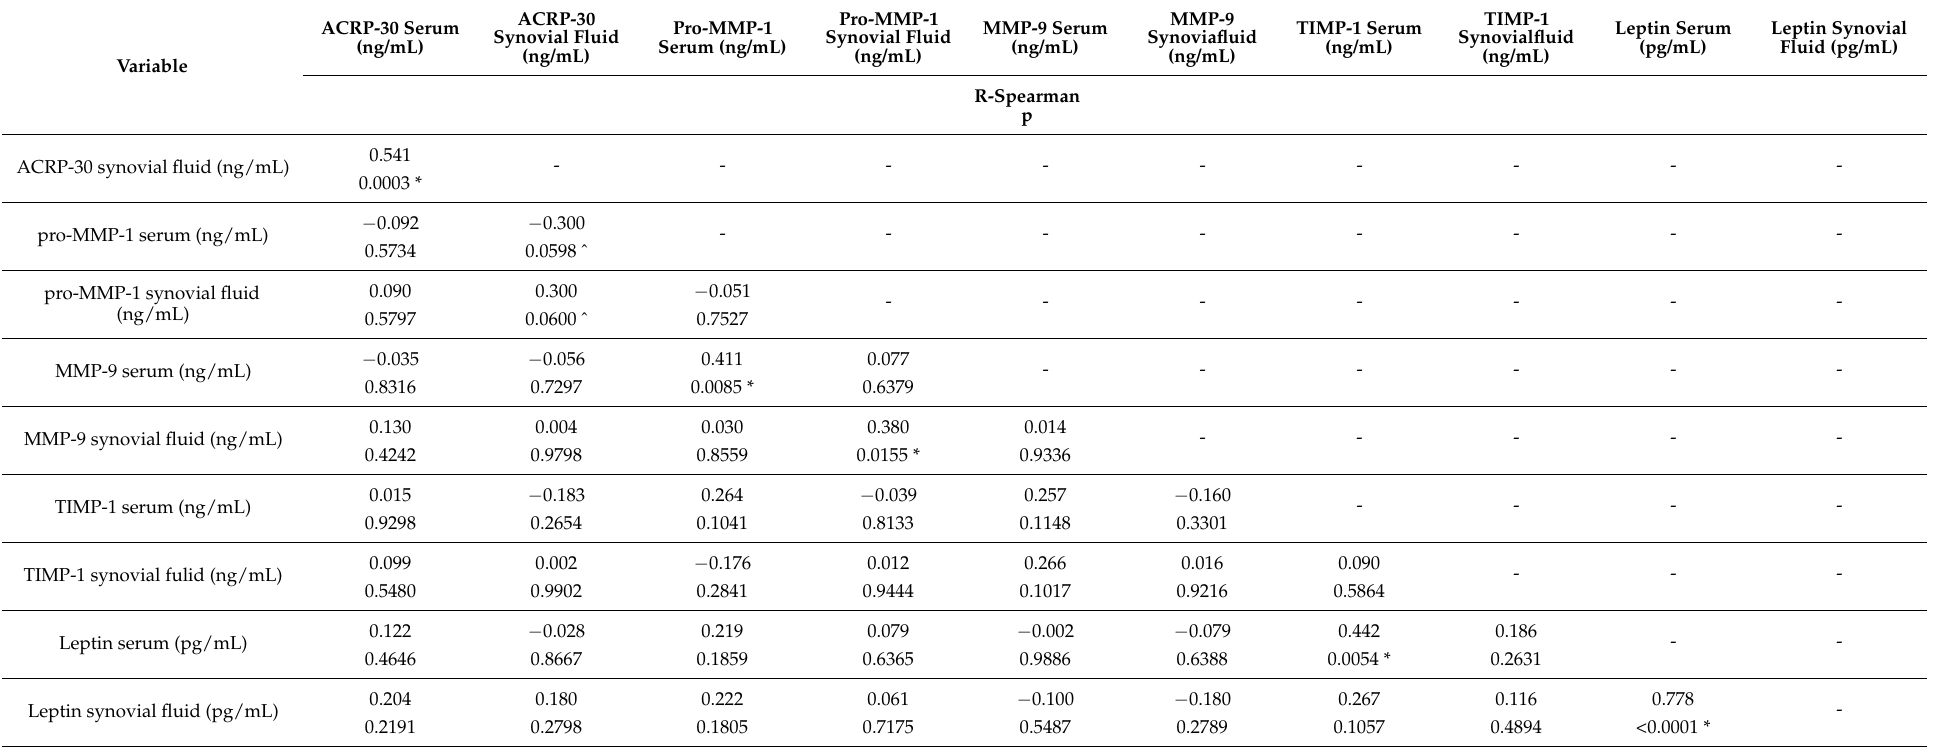
Table 4. Correlations between the levels of studied